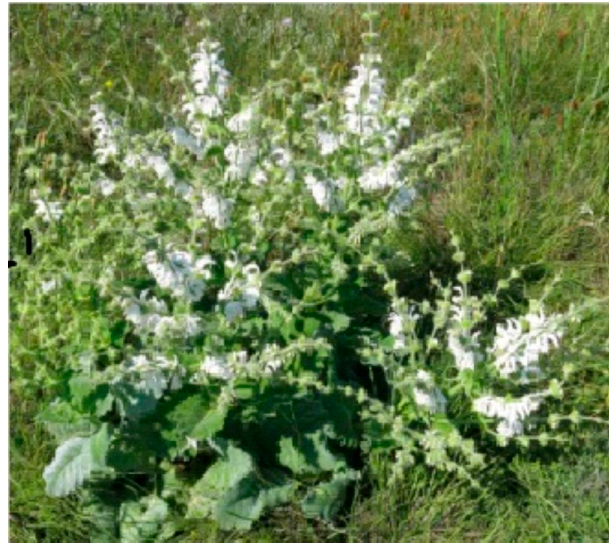
Figure 6. Salvia argentea at the full bloom stage.